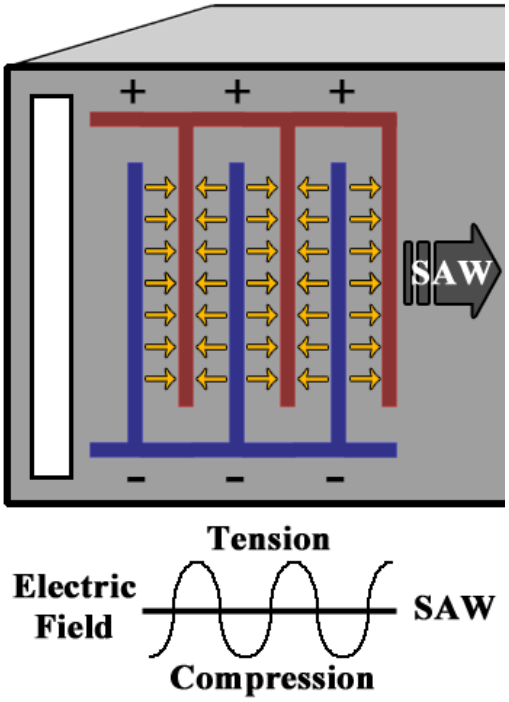
Figure 7. SAW generation phenomena in piezoelectric wafer [4].